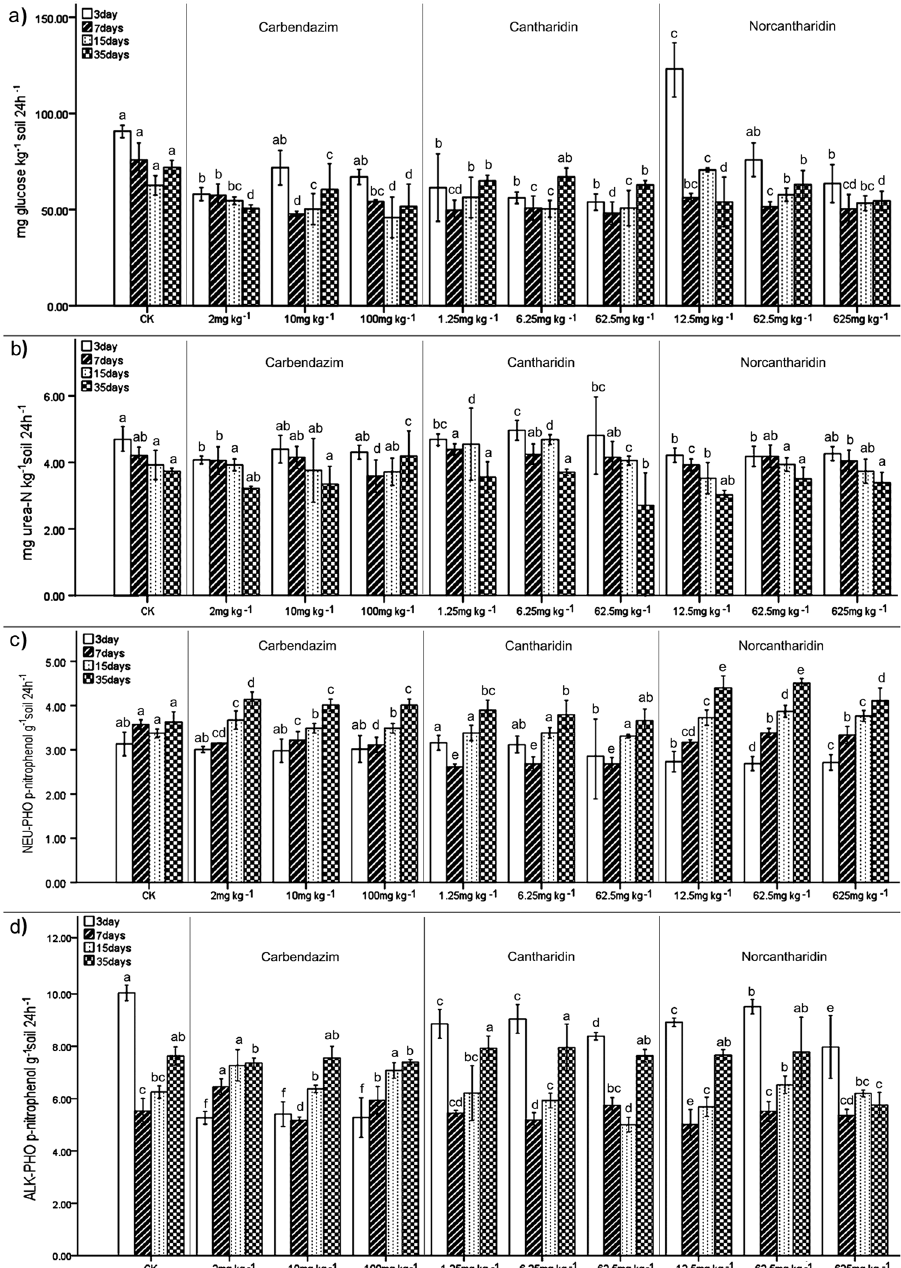
Figure 1. Effect of pesticides (cantharidin, norcantharidin, carbendazim) at recommended rate, five-fold and fifty-fold, on soil enzymatic activities. Mean values (n = 3) ± S.D. ( a ) Invertase activity, ( b ) Urease activity, ( c ) Neutral phosphate activity, ( d ) Alkaline phosphatase activity. Different letters indicate a statistically significant difference at the confidence level of 0.05 between treatments at the same